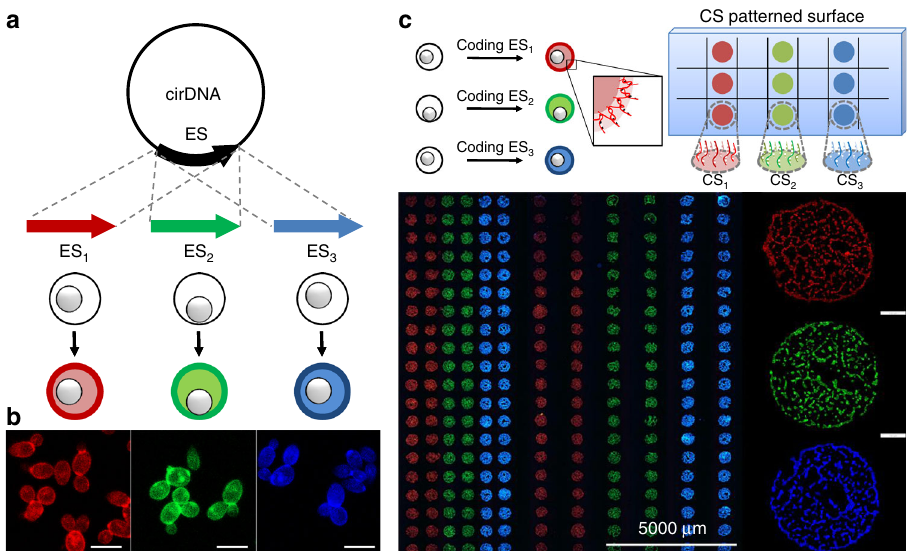
Fig. 6 Flexible encapsulation of cells by polymer encoded DNA cocoons. a The encoding sequences (ESs) are inserted into the cirDNA templates. b The yeast cells are encoded with sequence-speci fi c DNA cocoons. ESs (ES1, ES2 and ES3)-encoded cirDNAs are used as the replication templates. The cell- surface-fabricated DNA cocoons are labeled with the corresponding fl uorescent dye (TAMRA, FAM, and AMAC)-labeled oligonucleotides, F-ESs. The sequences are shown in Supplementary Table 2, and their relationships are shown in Supplementary Fig. 10. c The fl uorescent scanning images show that the encoded cells are captured in speci fi c capture zones on a glass slide that is prefunctionalized with the capture strands (CS, complementary to ES). The right part shows the enlarged capture zones with captured cells, and 990 ± 86 cells have been captured at each capture zone. Data are presented as the mean ± s.d. of three independent experiments. Scale bar, 100 mm